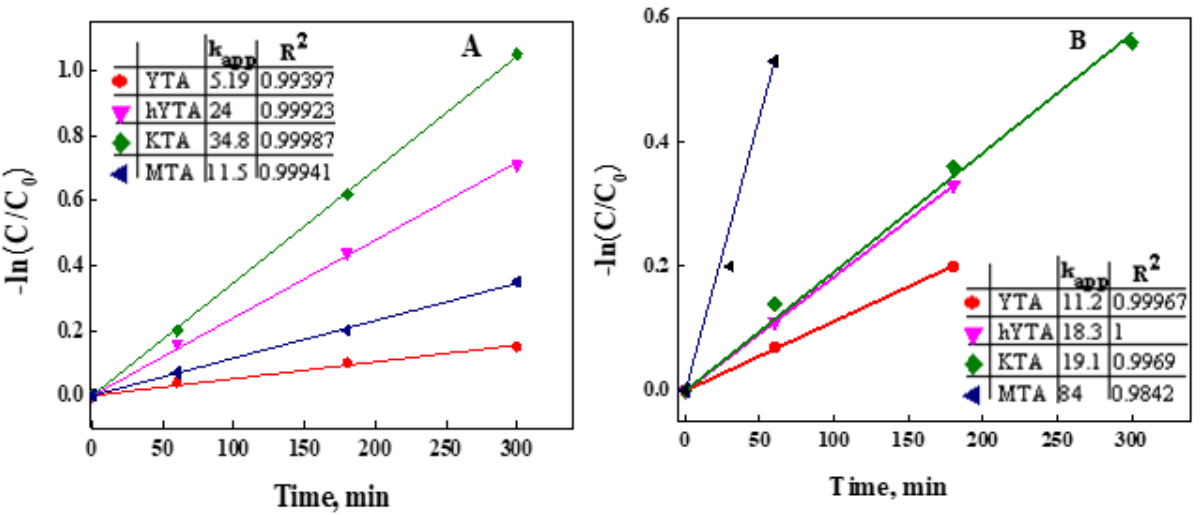
Figure 10. Kinetic and apparent rate constant k app values ( × 10 − 4 min − 1 ) of AMX photocatalytic degradation under UV ( A ) and visible light ( B ) irradiation.